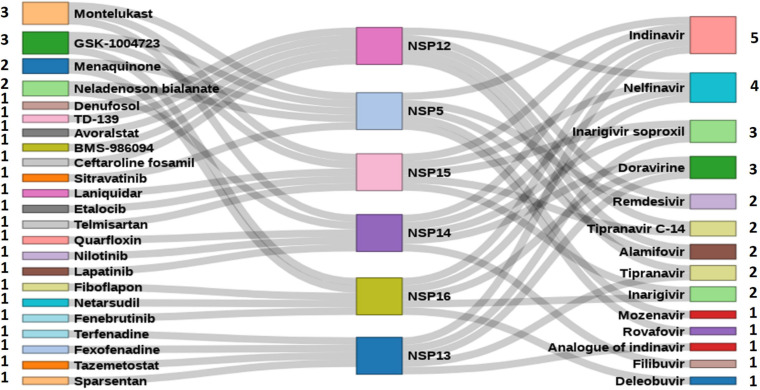
High-throughput virtual screened drugs targeting severe acute respiratory syndrome coronavirus 2 (SARS-CoV2) non-structural proteins (NSPs). Top five antivirals and other known drugs are shown at the right and left sides, respectively, along with the numbers indicating the target NSPs.